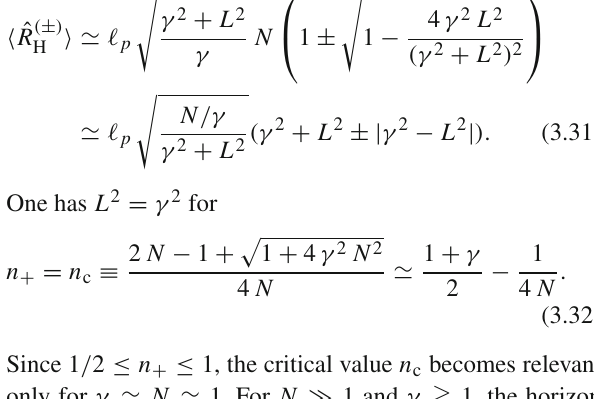
Fig. 1 Plots of P 02 (ρ ; λ μ ) as a function of ρ = r / (cid:7) ˆ R ( + ) (cid:7) ˆ R ( + ) (cid:6) / 4 ( solid line ), λ μ = (cid:7) ˆ R ( + ) H